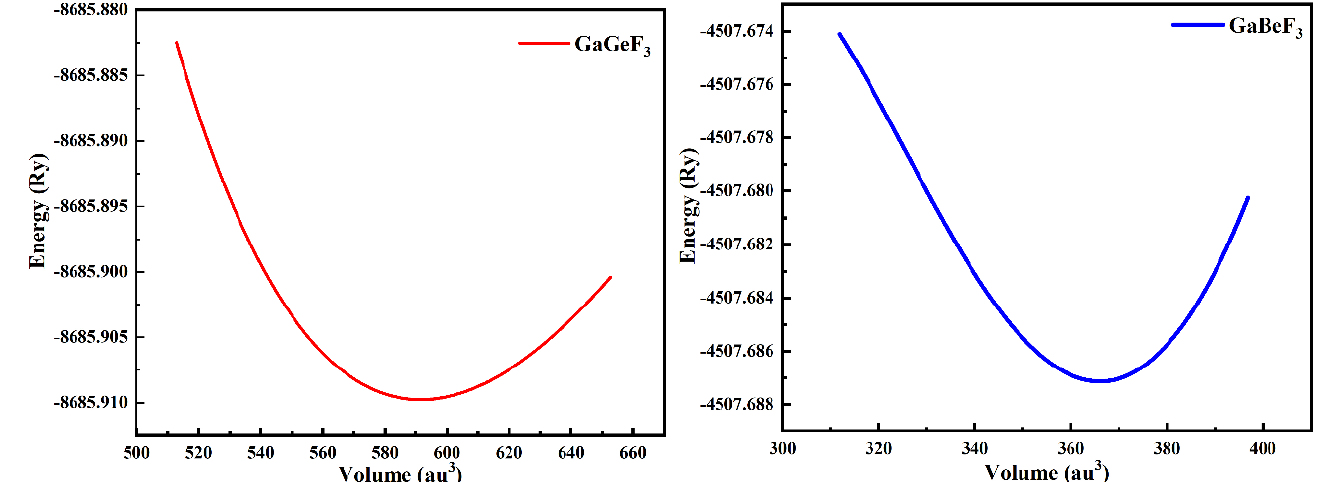
Figure 2. The optimized curve of GaMF 3 (M = Ga and Be) compounds, fitted by Birch–Murnaghan’s equation of state. Table 1. Optimized crystal unit cell characteristics of the GaMF 3 compound (M = Ge and Be). Structural